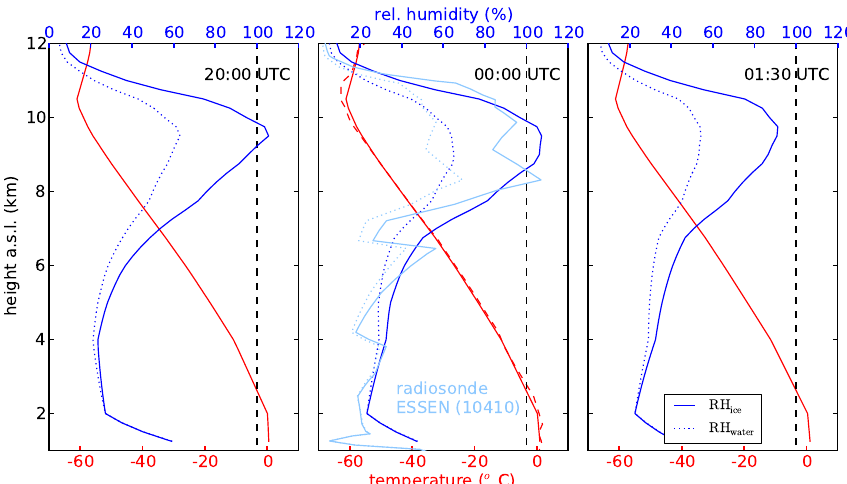
Fig. 3. Profiles of temperature (red lines) and rel. humidity with respect to water (RH water , dotted blue lines) and ice (RH ice , solid blue lines) at J¨ulich from ECMWF data (16 April 2010 at 20:00, and 17 April at 00:00, and 01:30UTC) and a radiosonde launched in Essen (station code 10410) on 17 April at 00:00UTC (red dashed line and light blue